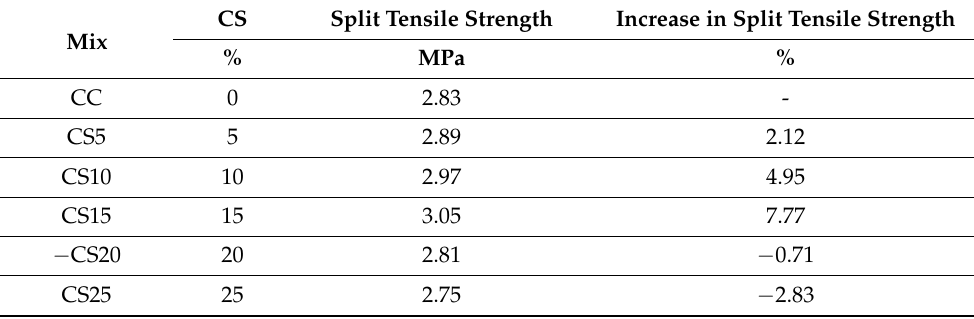
Table 4. Split tensile strength of CS concrete.